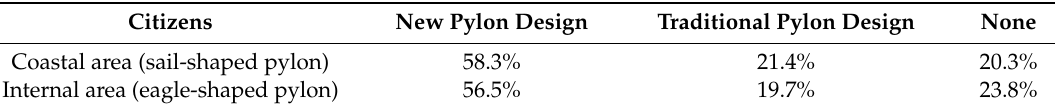
Table 11. Citizens’ preferences based on visual